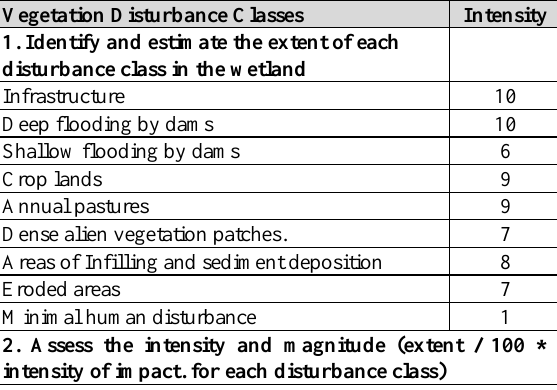
Table 1. UAV specifications